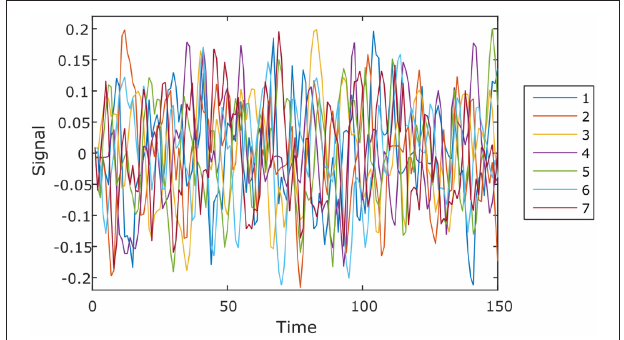
FIGURE 4 | Clustering accuracy against signal to noise ratio of the six techniques tested over 100 simulations, namely: SDLC, hierarchical